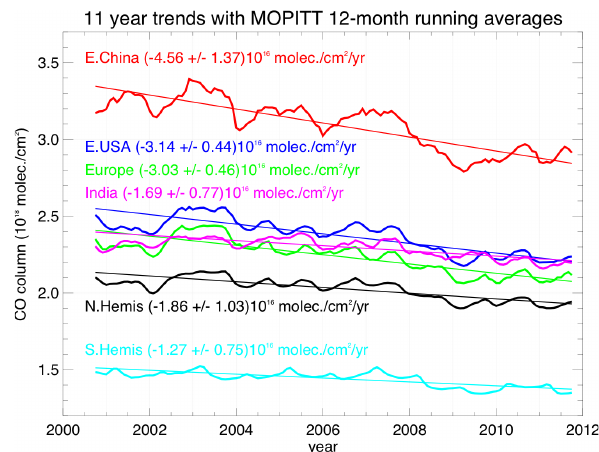
Figure 5. MOPITT 11-­‐year regional trends in total CO column change per year. Fig. 5. MOPITT 11-yr regional trends in total CO column change per year. Regional time series with 12-month running average and corresponding linear trends are indicated by the different colors, with slope and 1 σ error given in molecules/cm 2 yr − 1